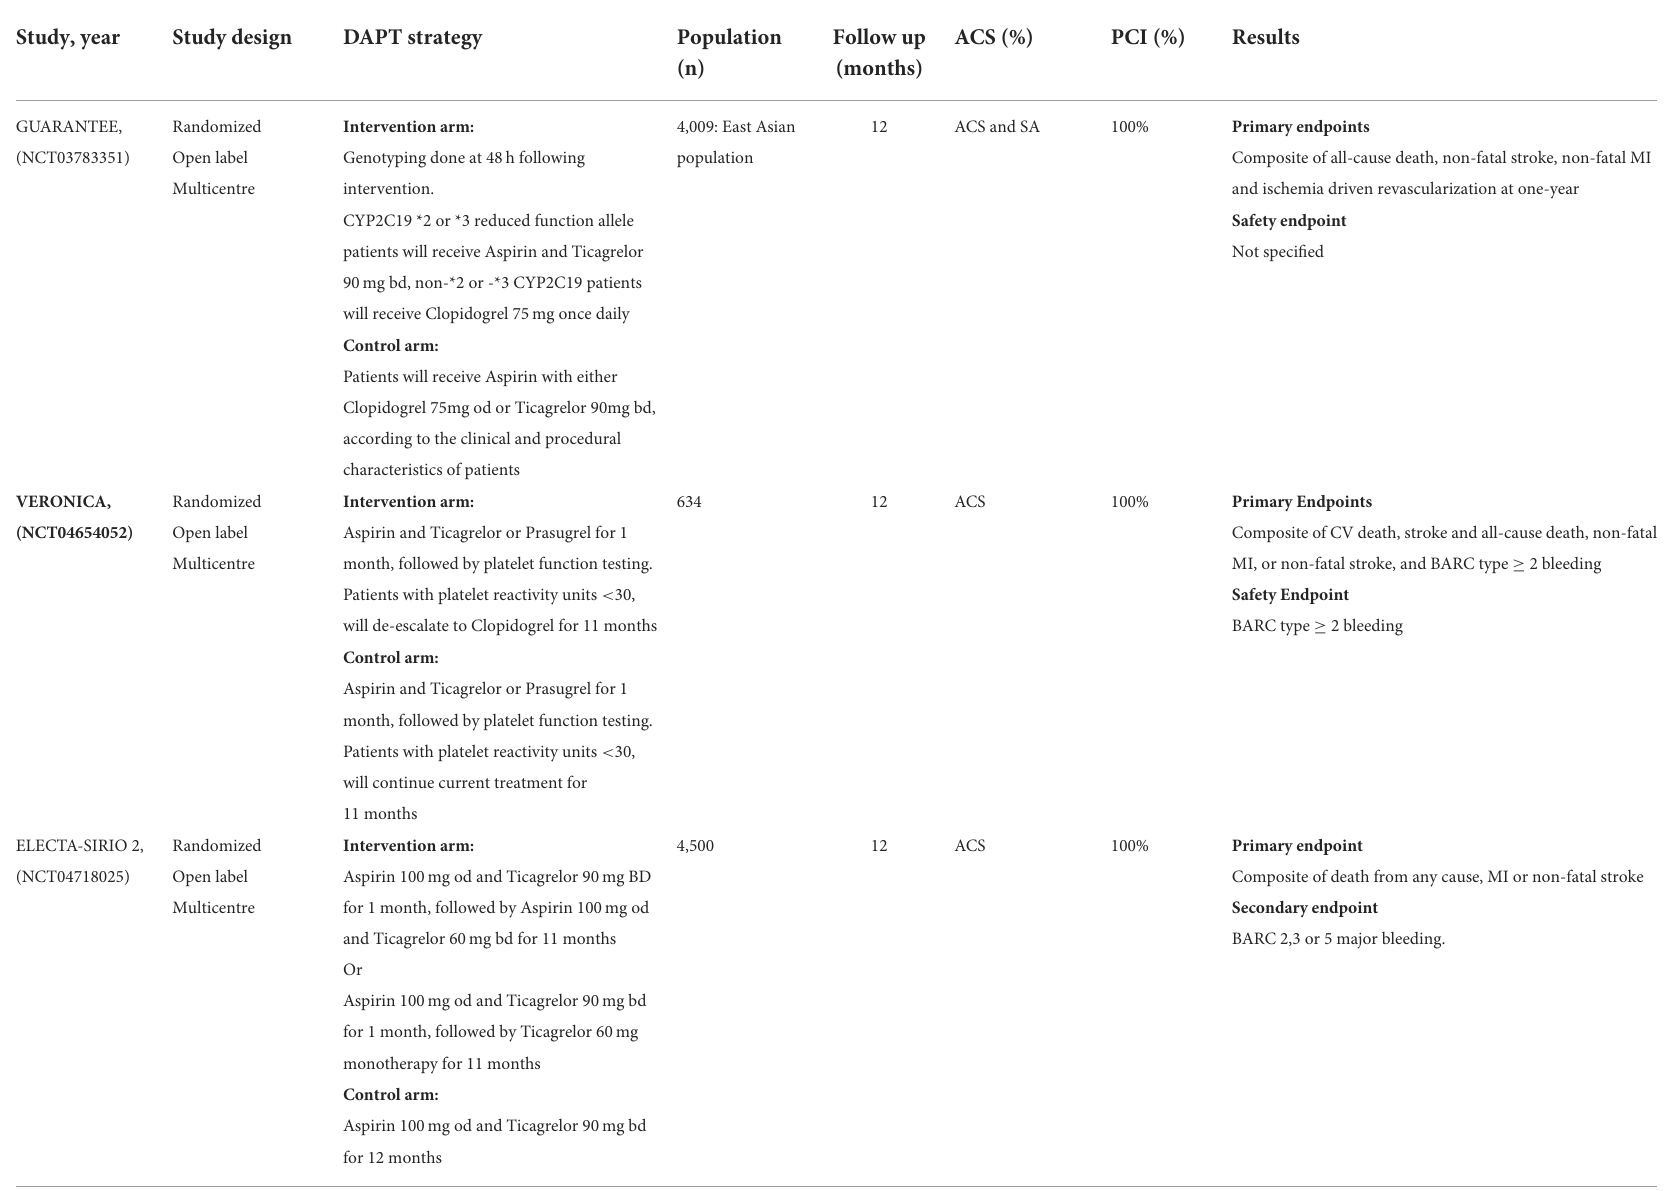
Studiesarelistedinchronologicalorderofpublicationdate.ThoseenrollingaparticularselectedpopulationsuchasEastAsianorelderlypatients,areindicated. ACS,acutecoronarysyndromes;BARC,BleedingAcademicResearchConsortium;CABG,coronaryarterybypassgraftingsurgery;CI,confidenceinterval;CV,cardiovascular;DAPT,dualantiplatelettherapy;HR,hazardratio;MI,myocardialinfarction; NSTEMI,non-ST-elevationmyocardialinfarction;PCI,percutaneouscoronaryintervention;PLATO,PLATeletinhibitionandpatientOutcomes;RR,riskreduction;SA,stableangina;STEMI,ST-elevationmyocardialinfarction;TIMI,Thrombolysisin